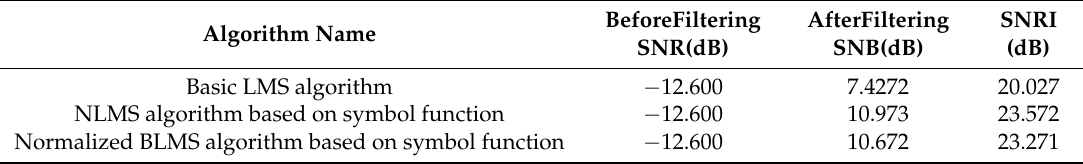
Table 3. Changes of SNR before and after denoising of ECG signals from the minicollector with PLI.